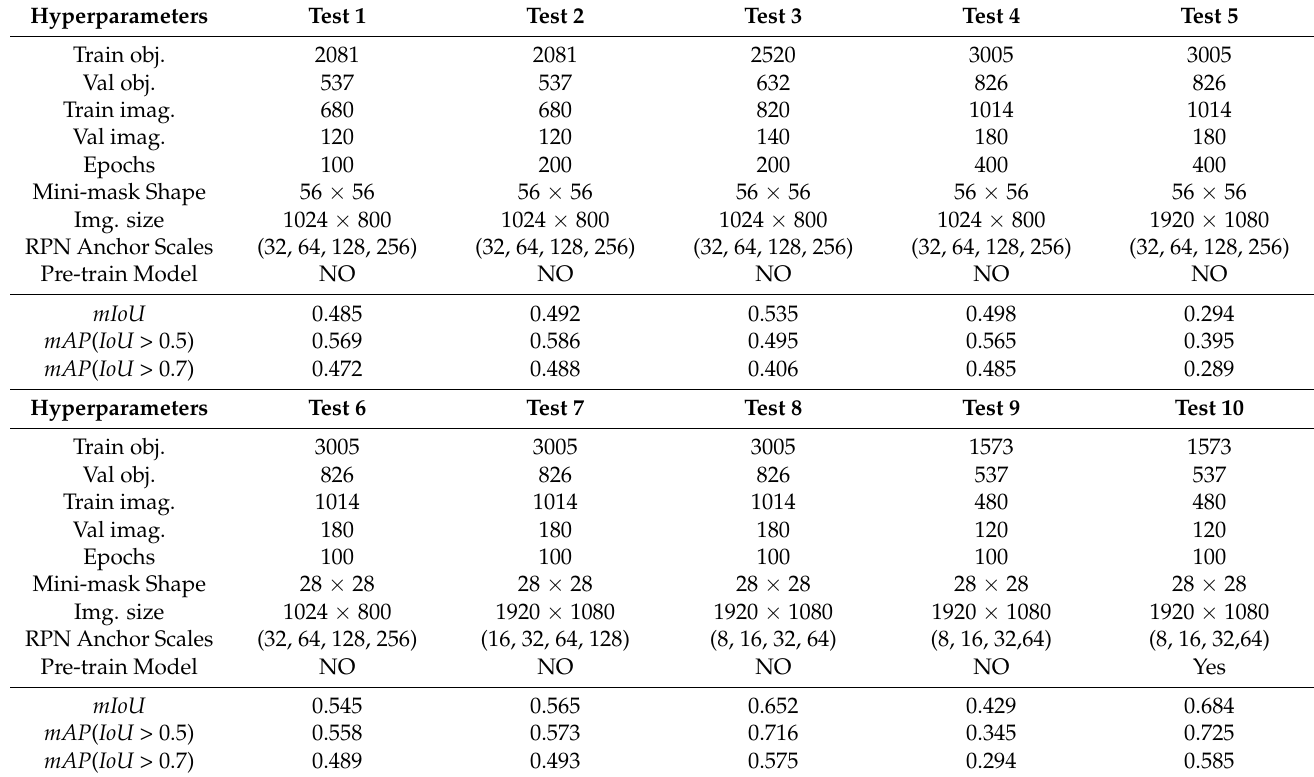
Table 3. Hyperparameters selection comparison